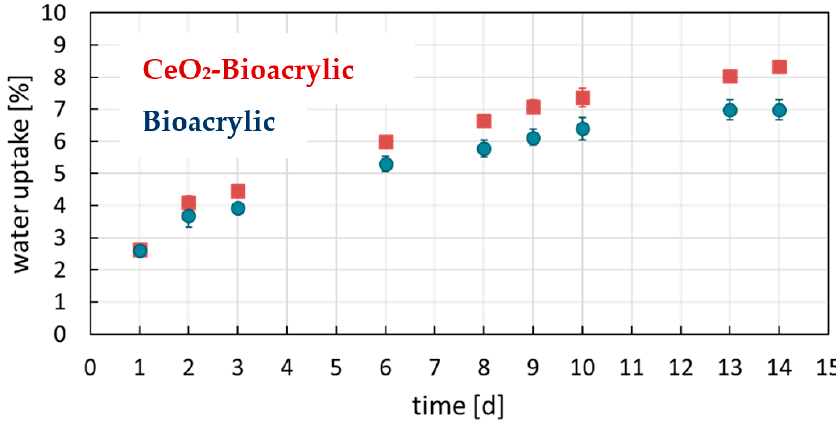
Figure 3. Free films formed at 24 ± 2 °C and 50 ± 5% relative humidity from ( a ) Bioacrylic latex and ( b ) hybrid CeO 2 -Bioacrylic latex.